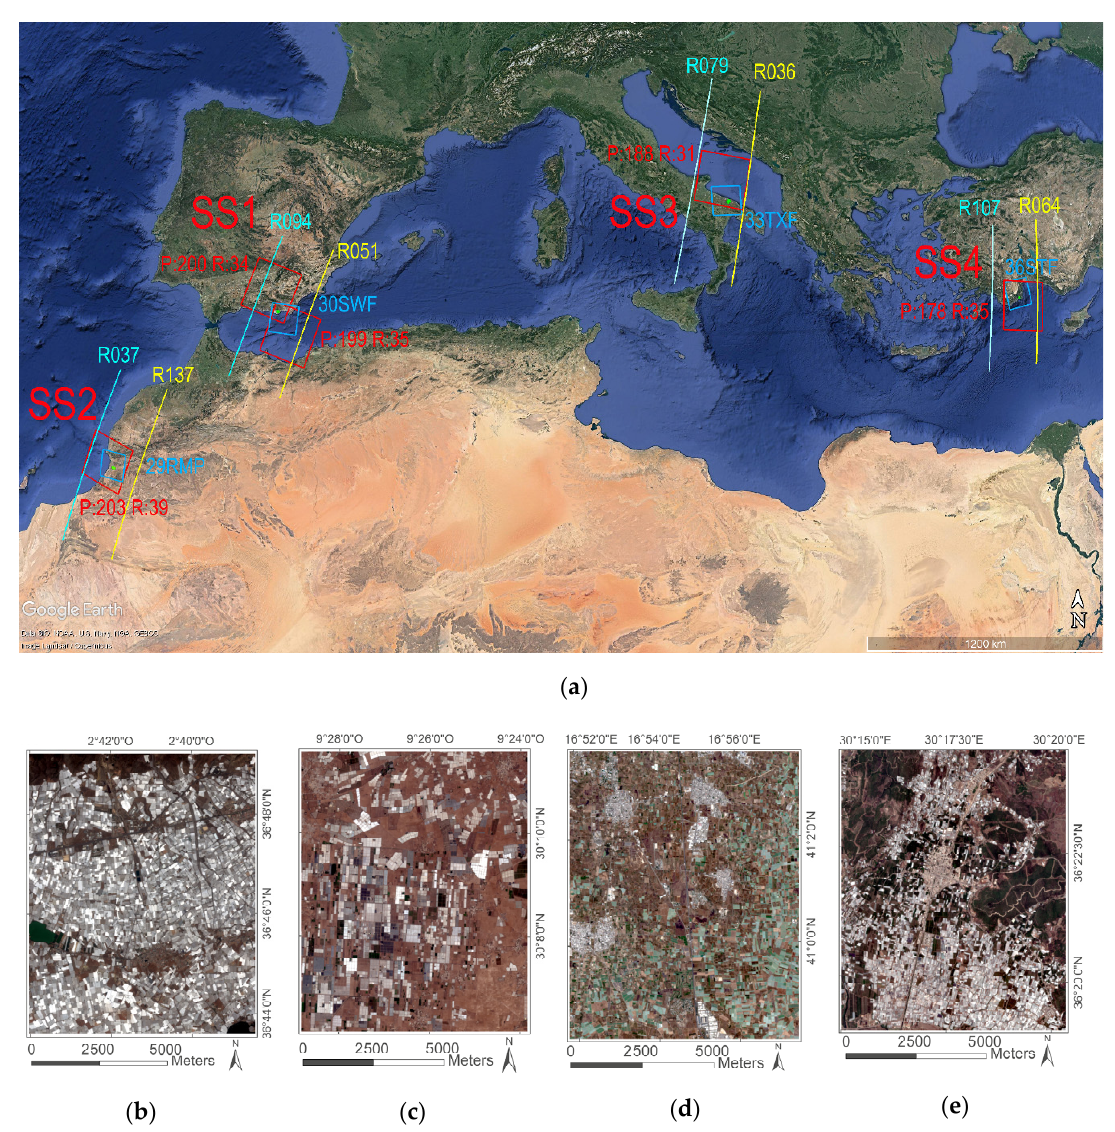
Figure 1. Location and detailed views of the four study sites: ( a ) Global location (SS1: Almería (Spain); SS2: Agadir (Morocco); SS3: Bari (Italy); SS4 Antalya (Turkey). Study site (little green polygon), Landsat 8 Path and Row (red rectangle), Sentinel-2 tile (blue rectangle) and Sentinel-2 relative orbits (blue and yellow lines); ( b ) Detailed view of the study site SS1; ( c ) SS2; ( d ) SS3; ( e ) SS4. All study site detailed views are area based on RGB Sentinel-2 images taken in July 2019.